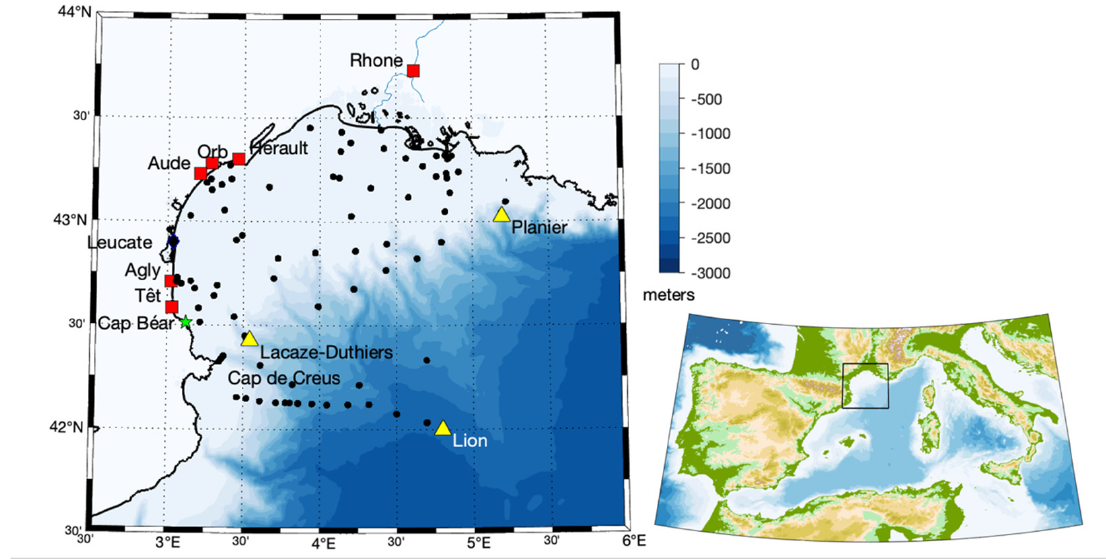
Figure 1. Map of the study area with the locations of the measurement sites (sampling stations in rivers—red squares; atmospheric station—green star, oceanic mooring lines with sediment traps in canyons and in the basin—yellow triangles, sediment cores on the shelf and in the basin—black